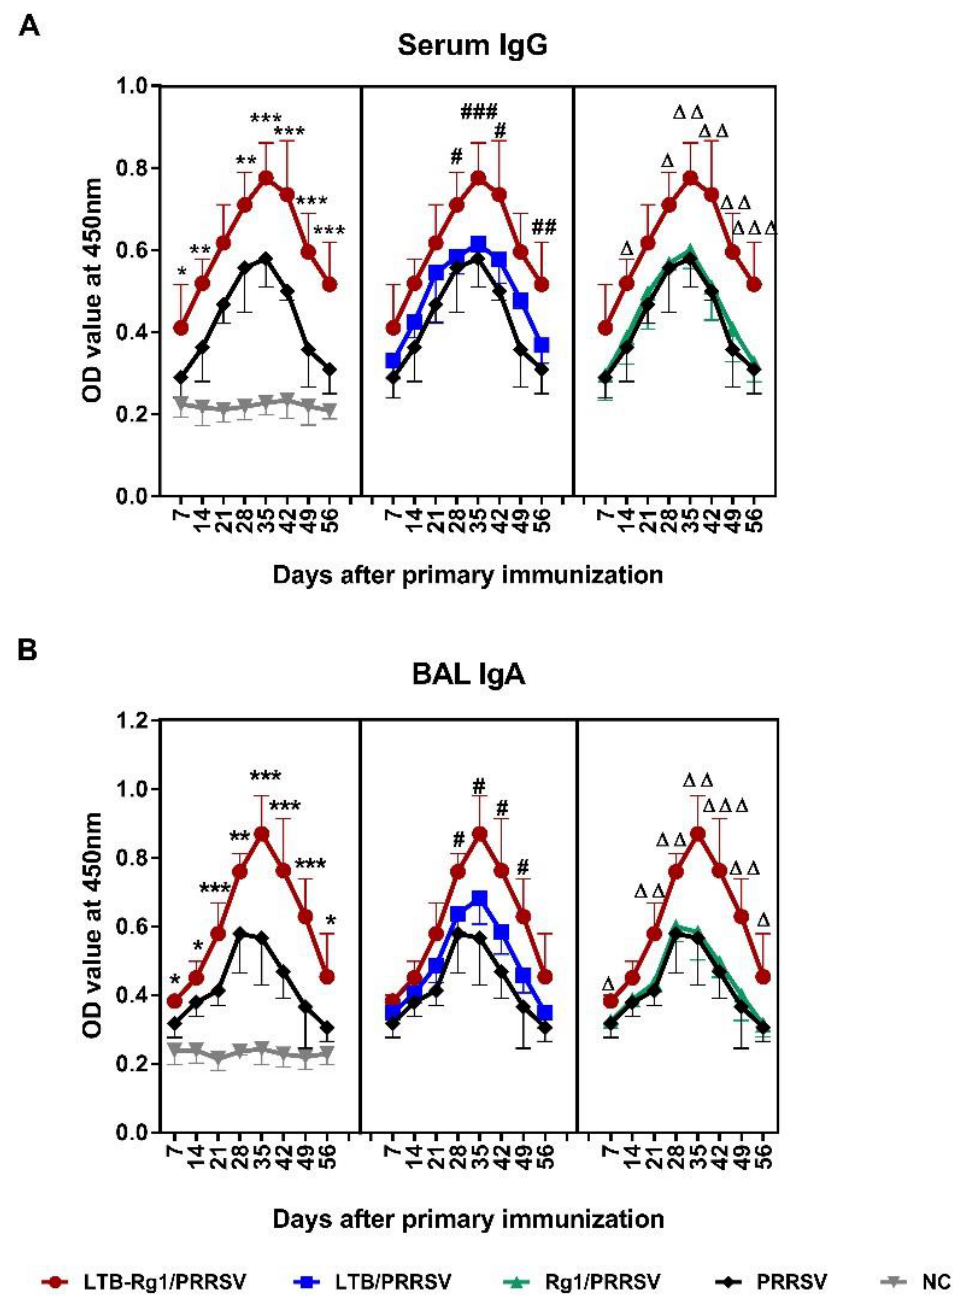
Figure 3. LTB-Rg1 significantly increased PRRSV-specific serum IgG and respiratory IgA responses. Mice ( n = 48/group) were immunized intranasally with PRRSV vaccine admixed with saline, LTB, Rg1, or LTB-Rg1. Non-immunized mice served as negative controls. On days 7, 14, 21, 28, 35, 42, 49, and 56, 6 mice were taken out from each group and euthanized. ( A ) Sera were collected to detect IgG response. ( B ) BAL fluid was collected to detect IgA response. Sub-plots show the comparison of LTB-Rg1/PRRSV with PRRSV, LTB/PRRSV, Rg1/PRRSV. Data are expressed as means ± SD. * p < 0.05, ** p < 0.01, *** p < 0.001 versus PRRSV group. # p < 0.05, ## p < 0.01, ### p < 0.001 versus LTB/PRRSV group. ∆ p < 0.05, ∆∆ p < 0.01, ∆∆∆ p < 0.001 versus Rg1/PRRSV